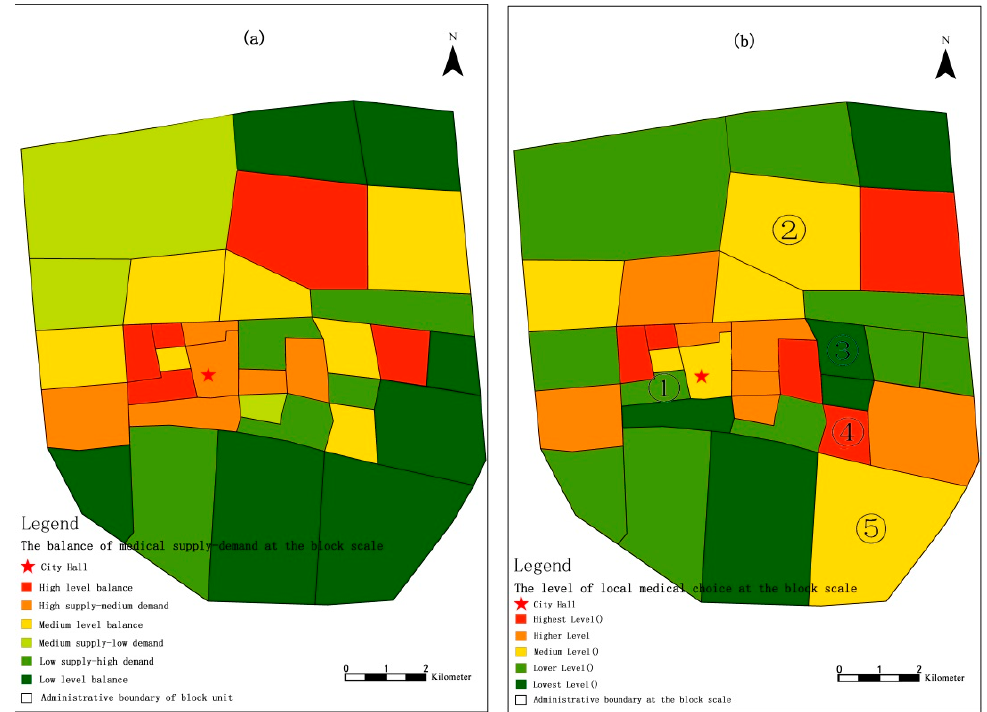
Figure 5. The balance degree of medical supply-demand ( a ) and local medical choice level ( b ).